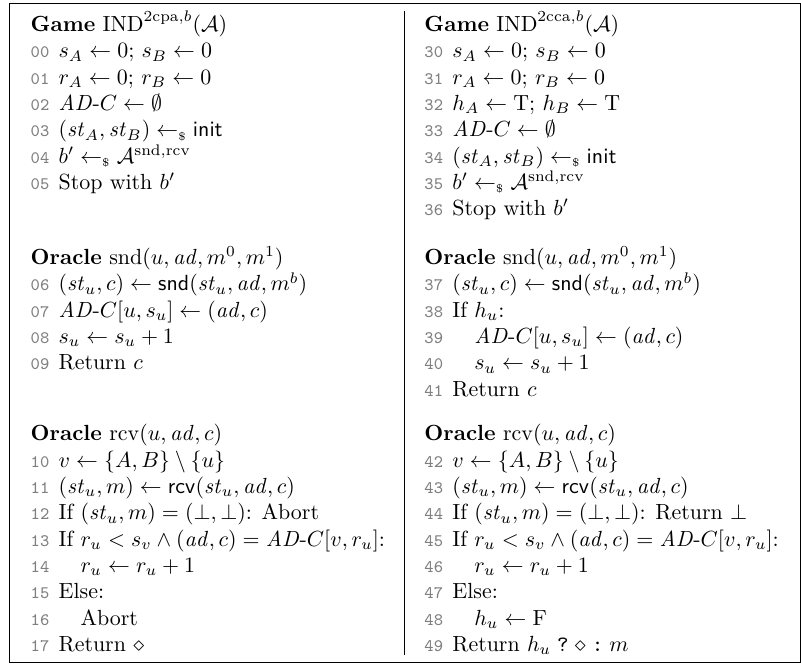
Figure 4: Games for confidentiality of bidirectional channels against chosen-plaintext (left) and chosen-ciphertext (right) attacks. We assume that once an oracle query for a participant results in the participant’s state being set to ⊥ , then no further query for that participant is accepted. We further assume u ∈ { A, B } , ad ∈ AD , m 0 , m 1 ∈ M , and c ∈ C for all such values provided by the adversary. We write ‘Abort’ as an abbreviation for ‘Stop with